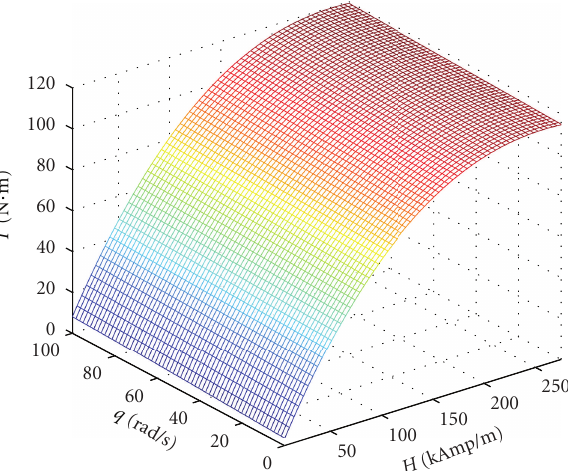
Figure 7: The transmission torque versus gap size h and inner radius R 1 .